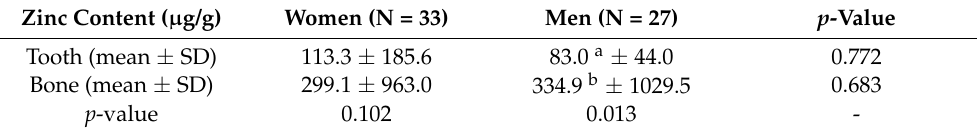
Table 10. Zinc content in tested samples taken from patients of different sexes.